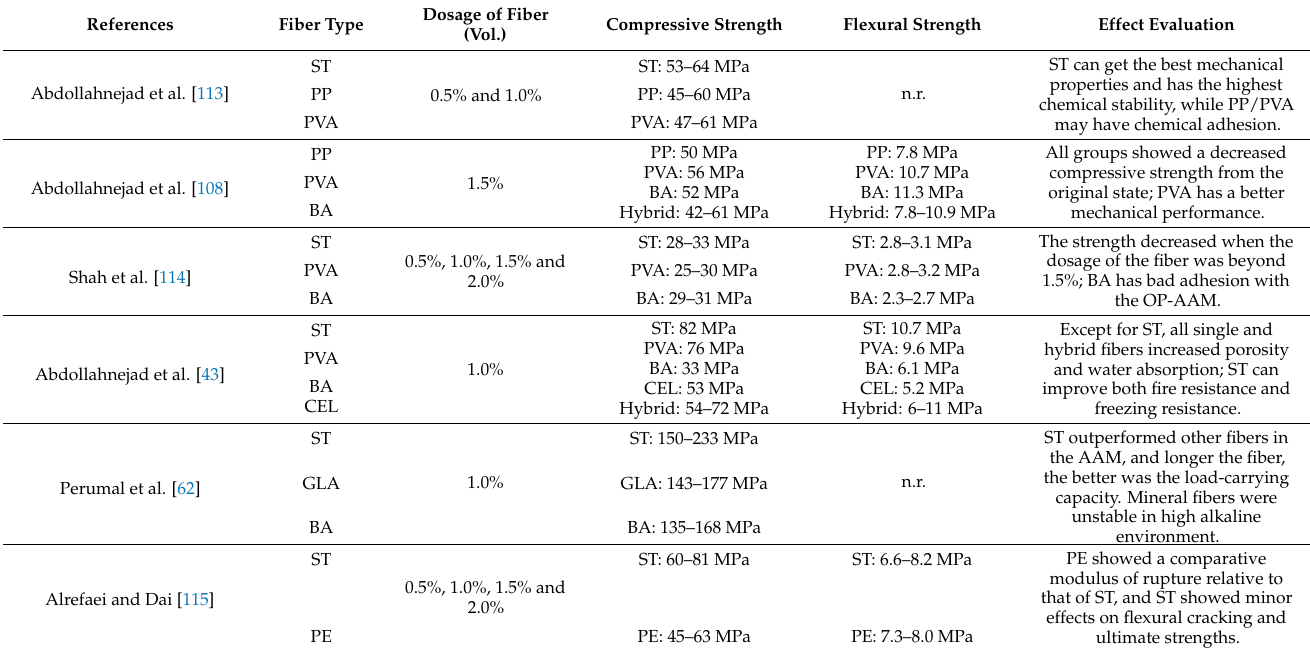
Table 3. Fiber type on the performance of one-part